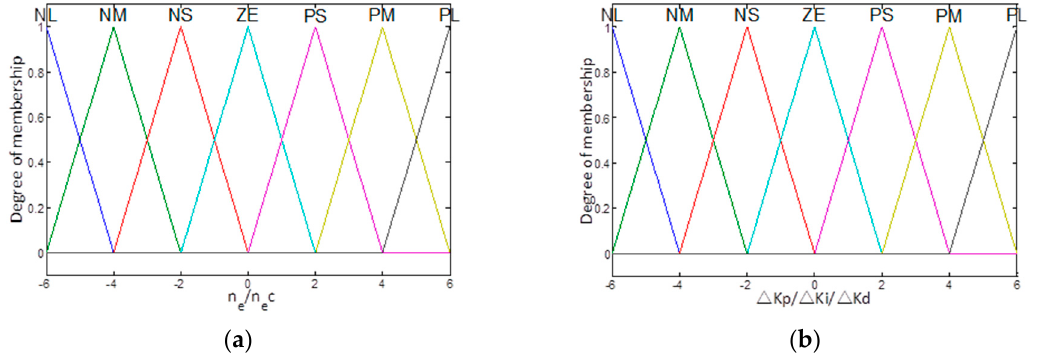
Figure 6. Membership functions of input and output: ( a ) Membership function of the input variables n e , n ec ; ( b ) Membership function of the output variables ∆ K p , ∆ K i , and ∆ K d